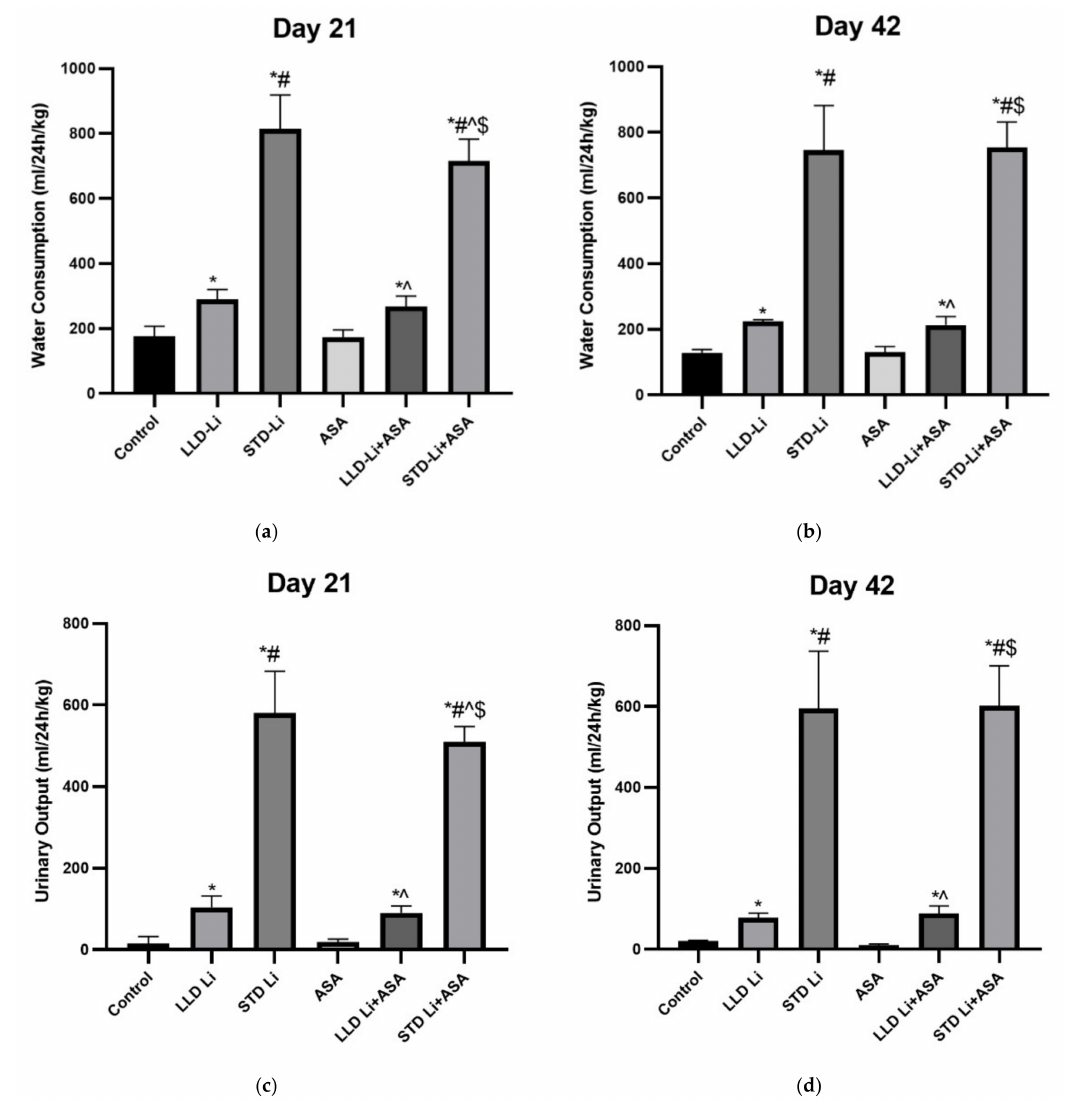
Figure 2. Water consumption and urinary output in aspirin + Li-treated rats. Rats were fed regular food (control) or lithium-containing food [0.1% (LLD) or 0.2% (STD)] for 42 days. Low-dose aspirin (1 mg/kg, ip) was administered alone or together with Li. At indicated days, 24 h water consumption ( a , b ) and urinary output ( c , d ) were measured as described in Materials and Methods. Results are means ± SEM of a single representative experiment out of two demonstrating a similar pattern with 9–12 (day 21) or 6 (day 42) rats per group in the depicted experiment. ( a ) Water consumption day 21, two-way ANOVA: ASA effect, F 1,59 = 7.938, p = 0.007; Li effect, F 2,59 = 635.4, p < 0.0001; aspirin x Li interaction, F 2,59 = 4.091, p = 0.021. Post hoc Fisher’s LSD test: Control vs. LLD-Li; Control vs. STD-Li, p < 0.0001; LLD-Li vs. STD-Li, p < 0.0001; LLD-Li vs. LLD-Li + ASA, p = 0.34; STD-Li vs. STD-Li + ASA, p = 0.0001. ( b ) Water consumption day 42, two-way ANOVA: ASA effect, F 1,30 = 2.689 × 10 − 5 , p = 0.9959; Li effect, F 2,30 = 320.5, p < 0.0001; aspirin X Li interaction: F2,30 = 0.069, p = 0.9328. Post hoc Fisher’s LSD test: Control vs. LLD-Li, p = 0.015; Control vs. STD-Li, p < 0.0001; LLD-Li vs. STD-Li, p < 0.0001; LLD-Li vs. LLD-Li + ASA, p = 0.77; STD-Li vs. STD-Li + ASA, p = 0.83. ( c ) Urinary output day 21, two-way ANOVA: ASA effect, F 1,59 = 4.528, p = 0.037; Li effect: F 2,59 = 729.5, p <0.0001; aspirin X Li interaction, F 2,59 = 3.384, p = 0.04. Post hoc Fisher’s LSD test: Control vs. LLD-Li, p = 0.0002; Control vs. STD-Li, p < 0.0001; LLD-Li vs. STD-Li, p < 0.0001; LLD-Li vs. LLD-Li + ASA, p = 0.523; STD-Li vs. STD-Li + ASA, p = 0.0009. ( d ) Urinary output day 42, two-way ANOVA: ASA effect, F 1,30 = 0.0044, p = 0.9475; Li effect, F 2,30 = 241.2, p < 0.0001; aspirin X Li interaction, F 2,30 = 0.07569, p = 0.9273. Post hoc Fisher’s LSD test: Control vs. LLD-Li, p < 0.0001; Control vs. STD-Li, p < 0.0001; LLD-Li vs. STD-Li, p < 0.0001; LLD-Li vs. LLD-Li + ASA, p = 0.80; STD-Li vs. STD-Li + ASA, p = 0.895. Asterisks and symbols denote the following: *— p < 0.05 vs. control; #— p < 0.05 vs. LLD-Li; ˆ— p < 0.05 vs. STD-Li; $— p < 0.05 vs. LLD-Li + ASA. Abbreviations: ASA—acetylsalicylic acid, LLD—low-low dose, Li—lithium, STD—standard